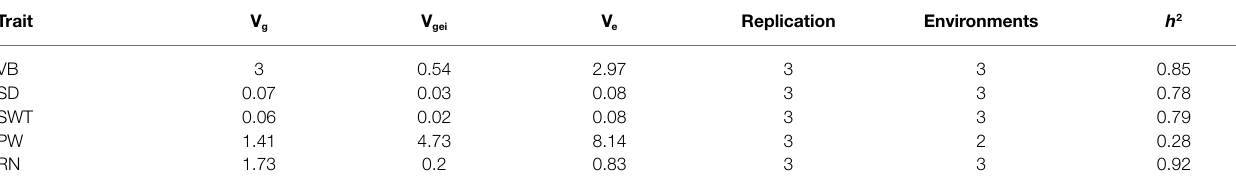
TABLE 2 | Variance components and heritability estimates for stem- and yield-related traits.